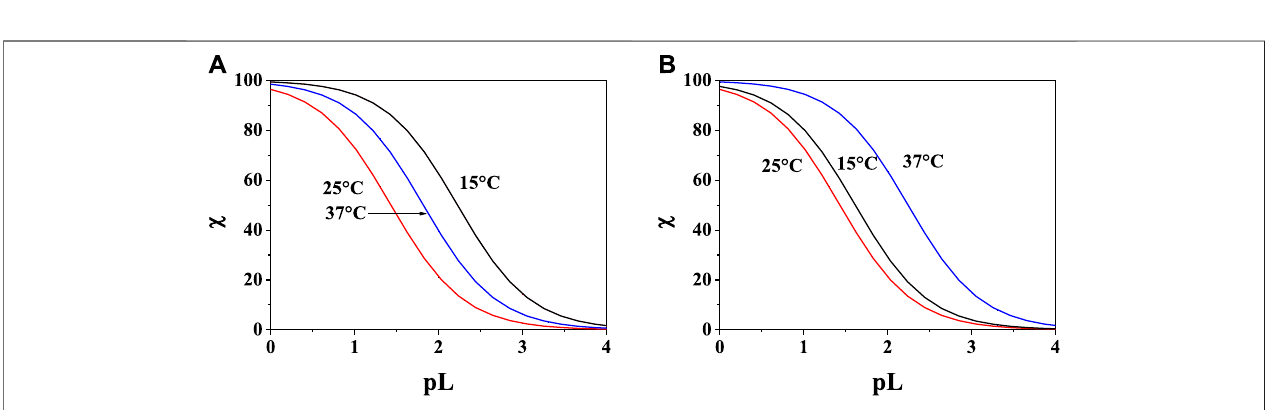
FIGURE 7 | Sum of the fractions of (A) Mg 2+ - PEA and (B) Mg 2+ - PPC species at pH = 7.4, and I = 0.15 mol L − 1 in NaCl.